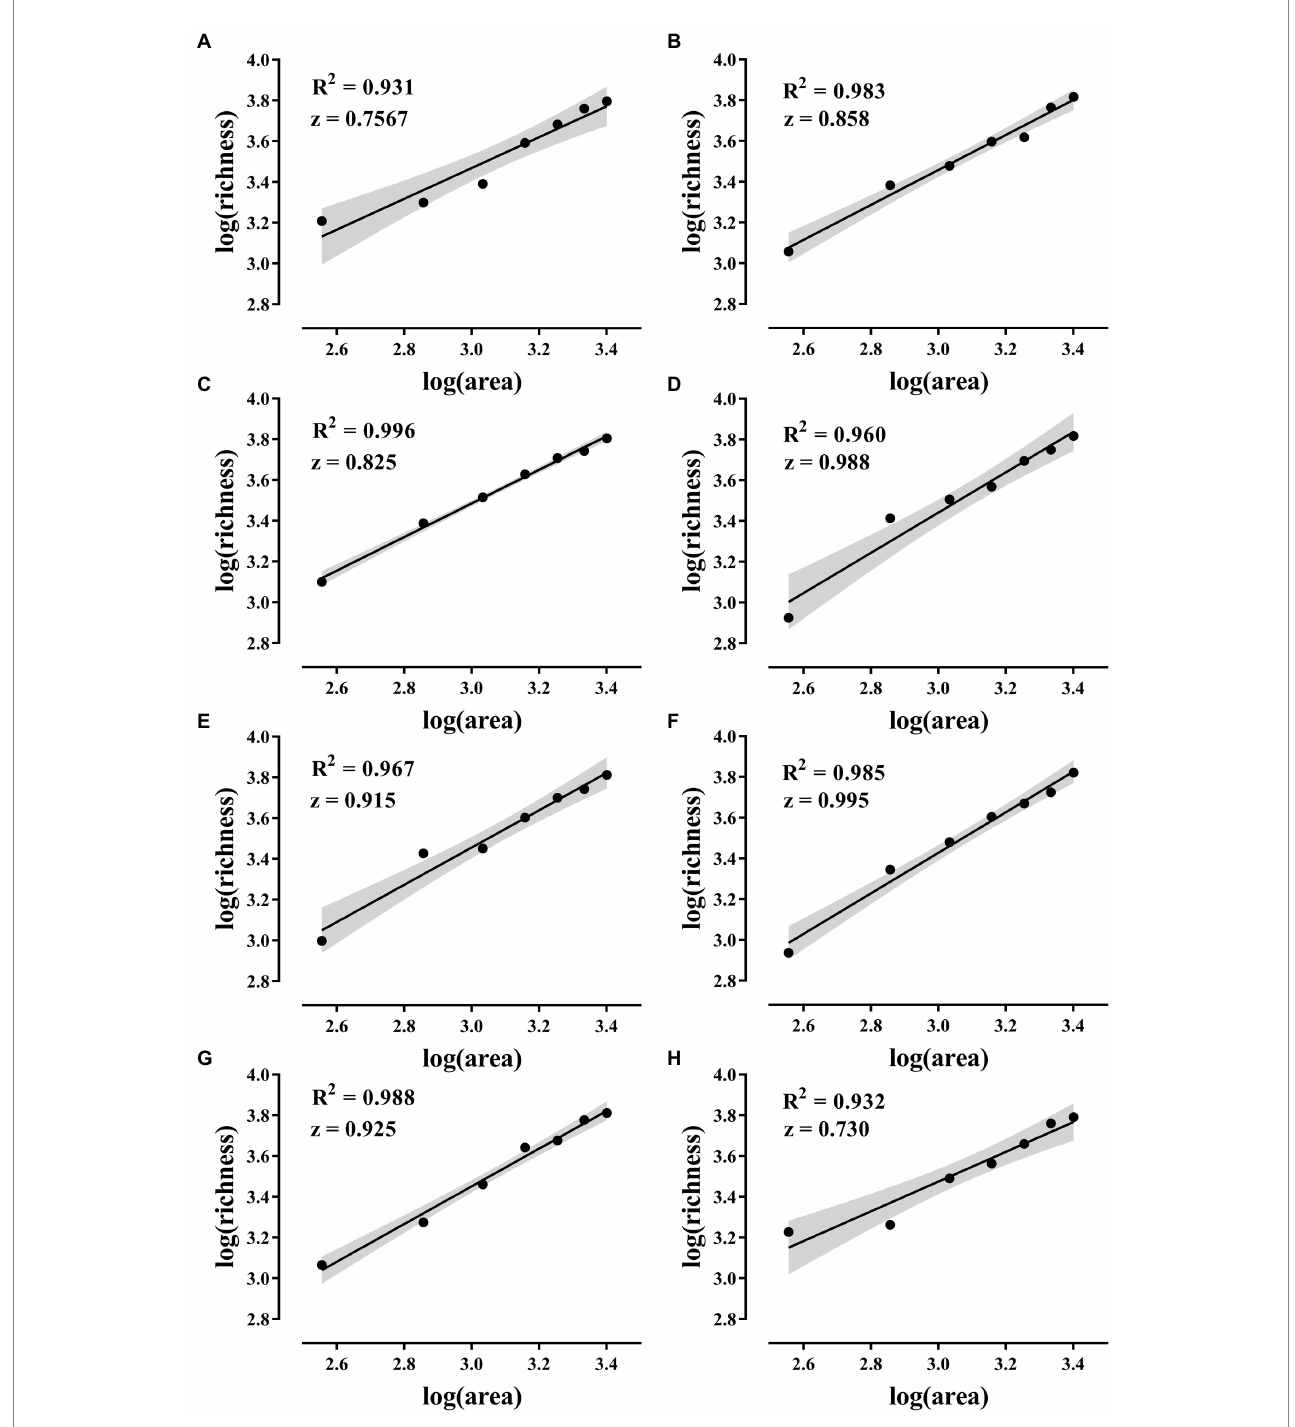
FIGURE 4 SAR curves. (A–H) The SAR curves of the eight island models in Figure 1. The solid line in the figure shows the fitted curve. SAR was constructed using a linear model in log–log space with log(S) = C + z * log(A) (S is species richness, A is area, C and z are fitting parameters, where z is the slope). The gray areas are 95% confidence intervals and the p -values of the fitted curves are all less than